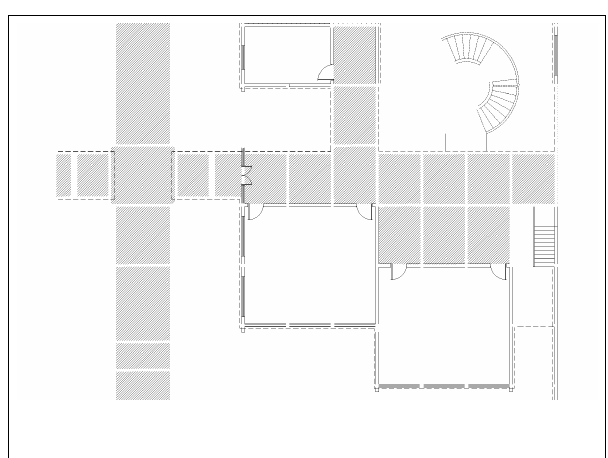
Figure 8: Floor-plan of a part of the first floor of the Himalaya building